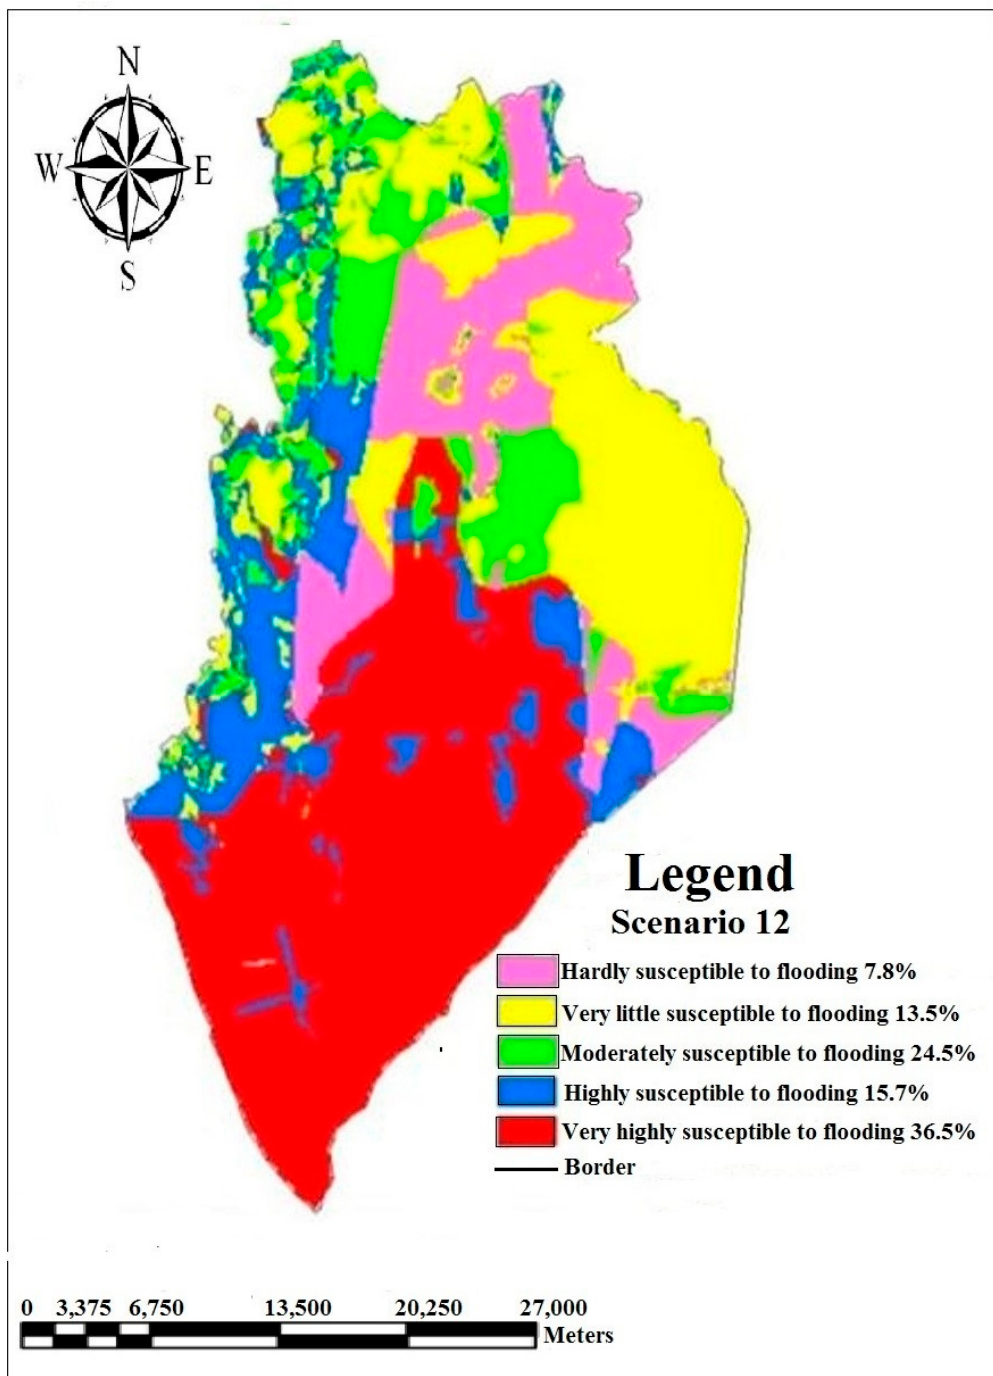
Figure A3. Importance of major rainfall (Scenario 12).